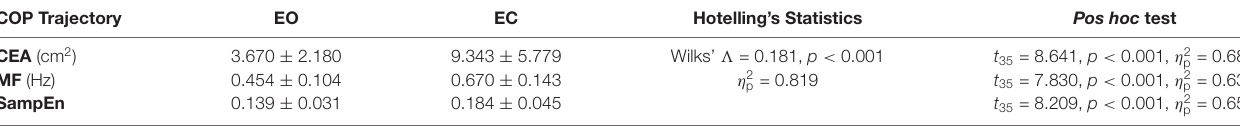
TABLE 2 | The contrast population means of center-of-pressure (COP) variables between the eyes-open (EO) and eyes-closed (EC) conditions.